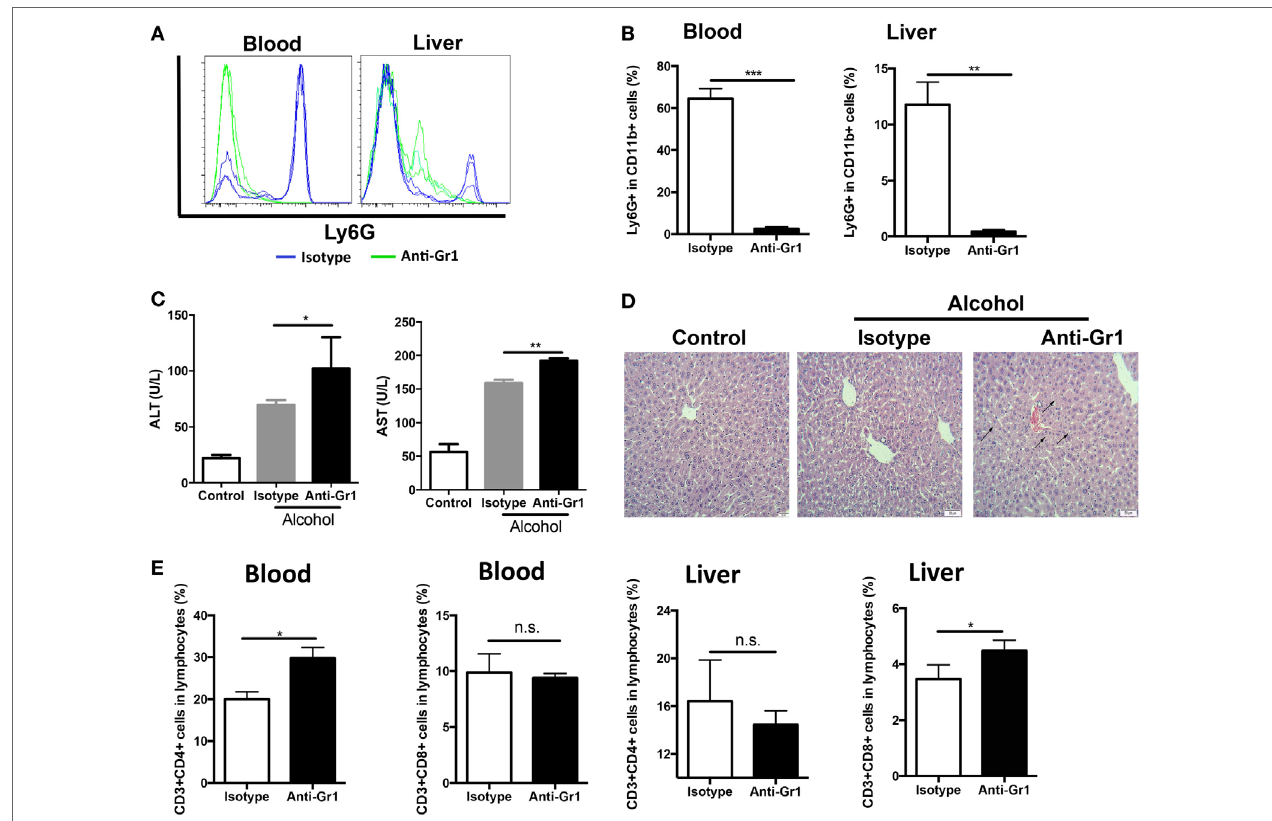
FigUre 2 | Depletion of granulocytic-MDSCs (G-MDSCs) population aggravated acute alcoholic liver injury. Anti-Gr1 (RB6-8C5) or isotype IgG2b antibody were injected i.p. into mice and then treated with ethanol ( n = 6 for each group). The populations of myeloid-derived suppressor cells (MDSCs) and T cells in blood and liver were determined by flow cytometer and then liver function was evaluated via serological and histological examination. (a) Representative histogram images and (B) quantification of flow cytometric analyses of G-MDSCs populations in blood and liver of mice treated with anti-Gr1 or vehicle. G-MDSCs cells were effectively depleted following single anti-Gr1 antibody injection. (c) The serum alanine aminotransferase (ALT) and aspartate aminotransferase (AST) levels in mice treated with anti-Gr1 were significant higher than that of vehicle. (D) The representative H&E staining images of liver tissue from normal mice, ethanol model mice with vehicle injection, and ethanol mice with anti-Gr1 injection. The hepatocellular apoptosis and single cell necrosis were indicated by arrows. (e) Population of T helper cells and cytotoxic T cells in blood and liver of model mice and anti-Gr1 treated mice. Data were analyzed as mean value ± SD and Student’s T -test was used to assess the result significance. * p < 0.05, ** p < 0.01, *** p < 0.001, compared with the control group; n.s., not